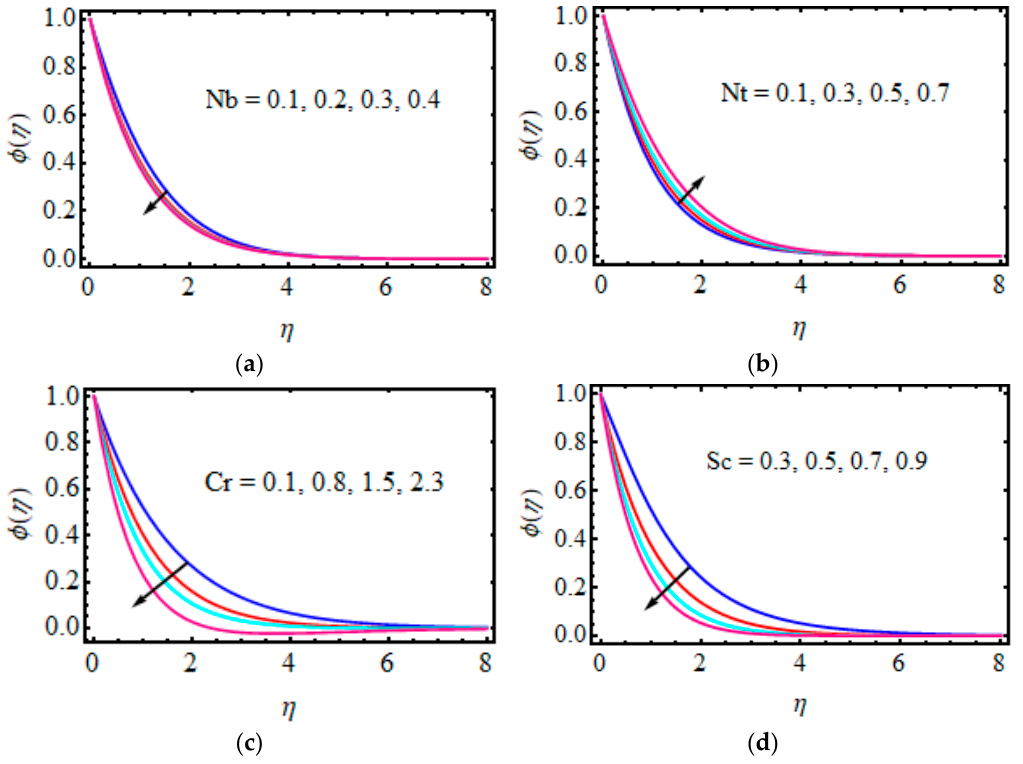
Figure 4. ( a – f ). The impact of the numerous variables of 𝜃(cid:4666)𝜂(cid:4667): ( a ) 𝜆 (cid:2869) , ( b ) 𝑅𝑑 , ( c ) 𝑁𝑡, ( d ) 𝑁𝑏, ( e ) 𝐵𝑖 and ( f ) 𝑃𝑟 .